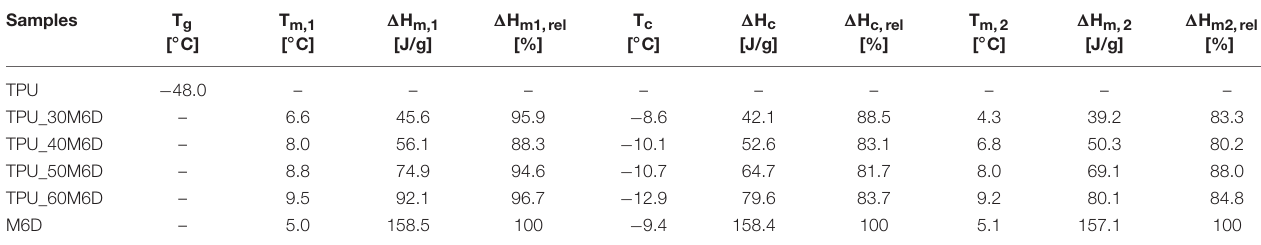
TABLE 2 | Results of DSC tests on neat TPU and its relative polymer blends.